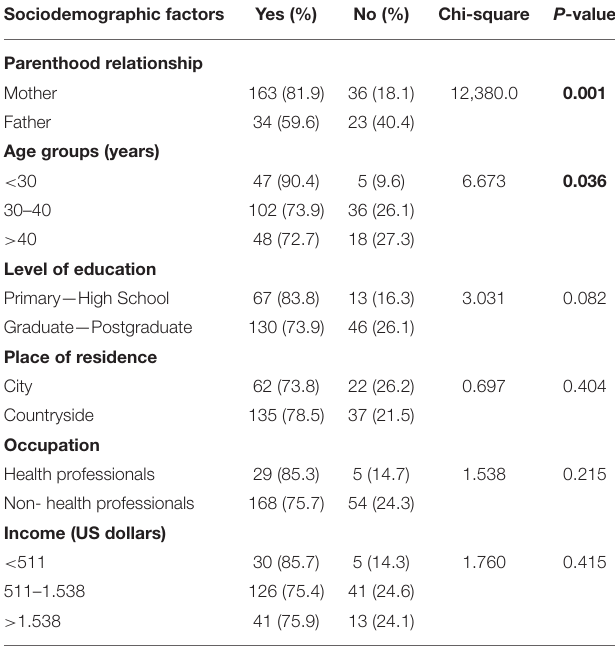
TABLE 5 | Parents’ responses regarding whether they were concerned about taking their children for dental treatment during